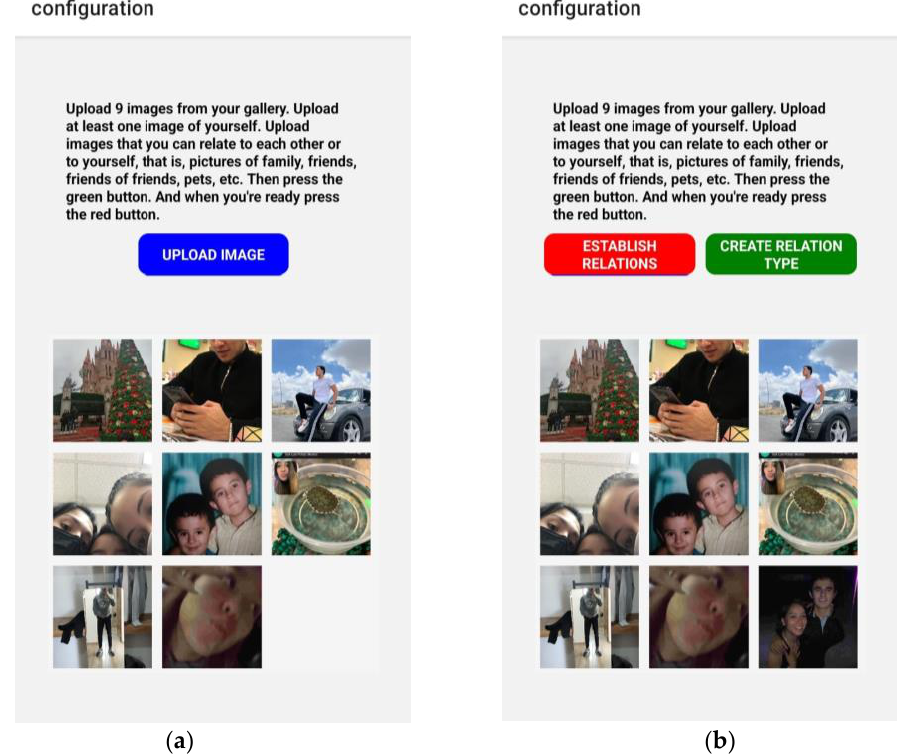
Figure 3. ( a ) Image-upload screen; ( b ) Image-upload screen once user has uploaded 9 images.